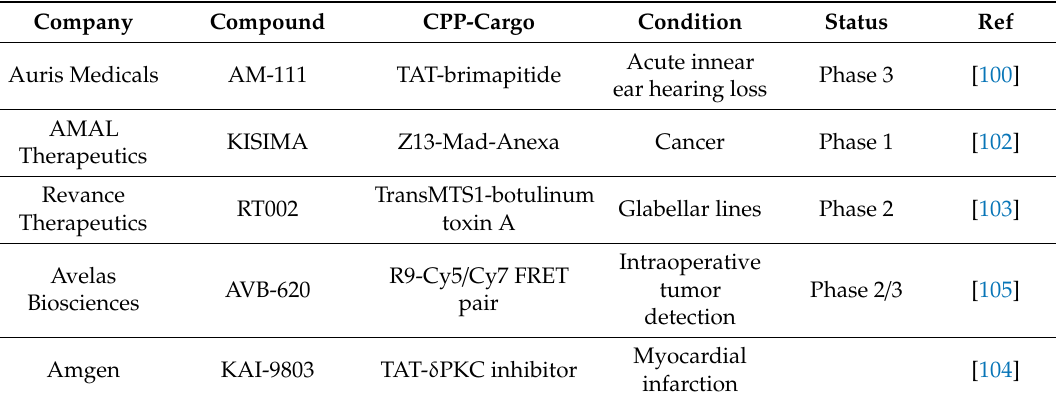
Table 2. Examples of CPP-based strategies under clinical